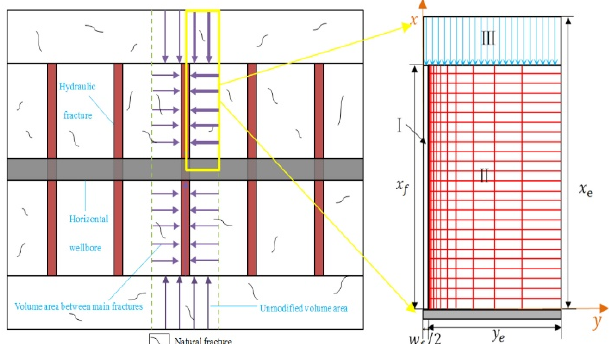
Figure 2. Physical model of seepage flow in fractured horizontal wells in tight oil reservoirs.